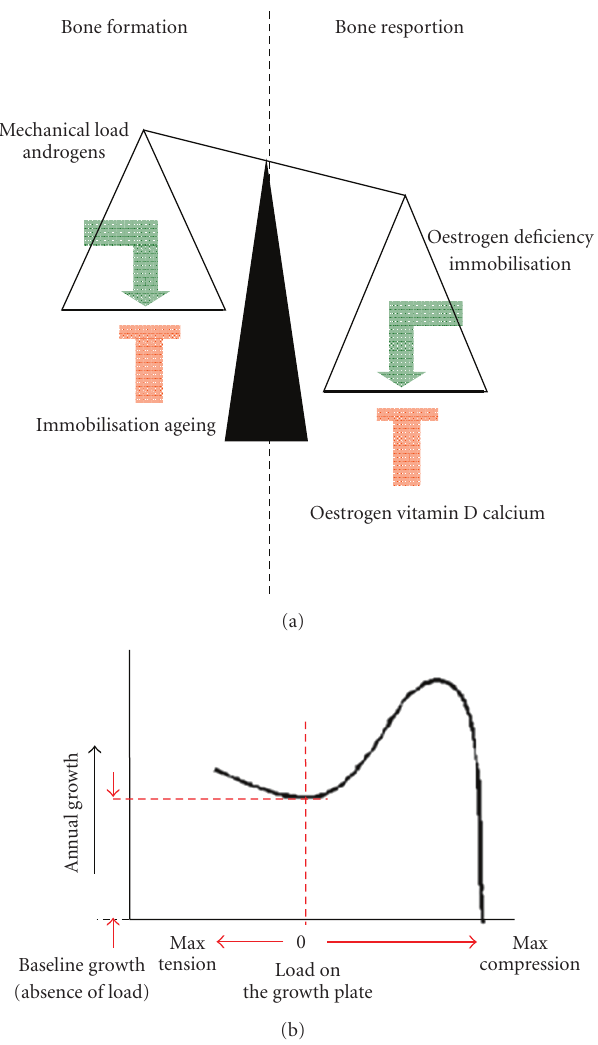
Figure 1: (a) A schematic representation of processes that may influence bone formation and resorption [3]. (b) A graph illustrat- ing the Hueter-Volkman law [4].